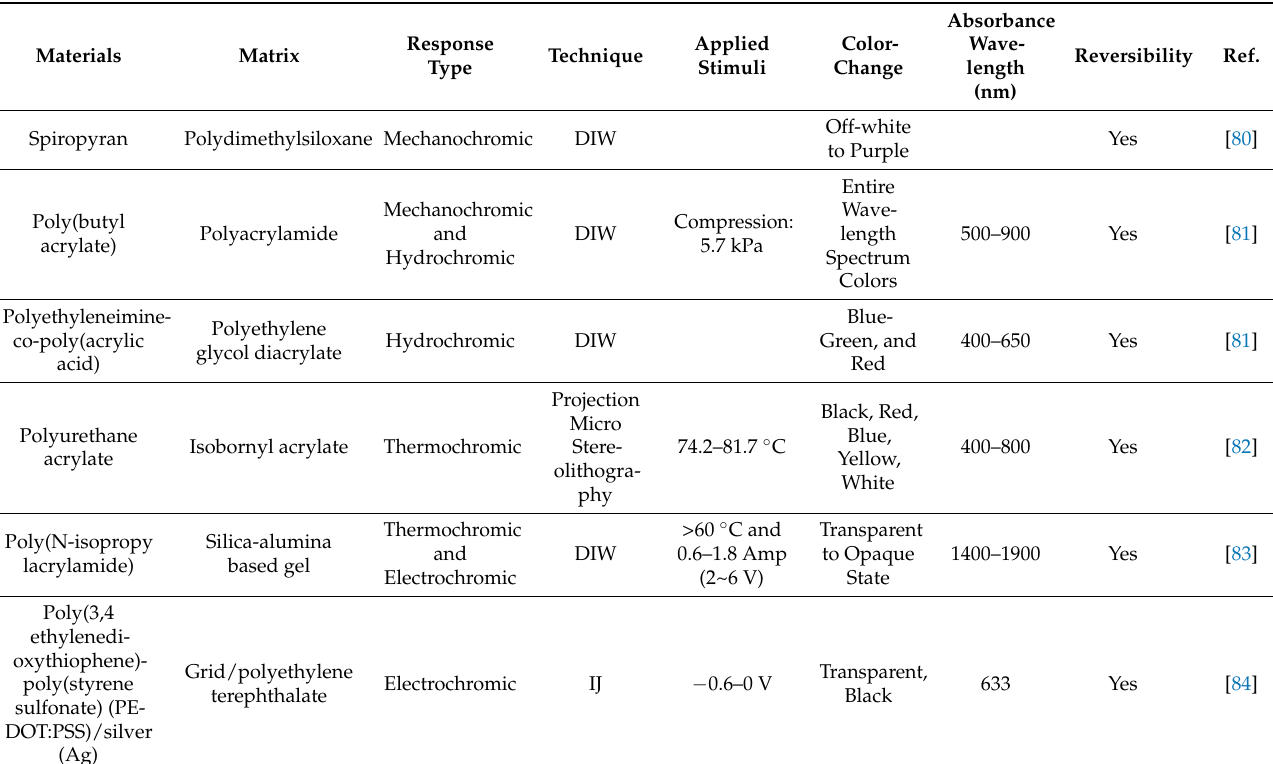
Table 5. Summary of chromic materials and their properties that have been recently processed through AM techniques.